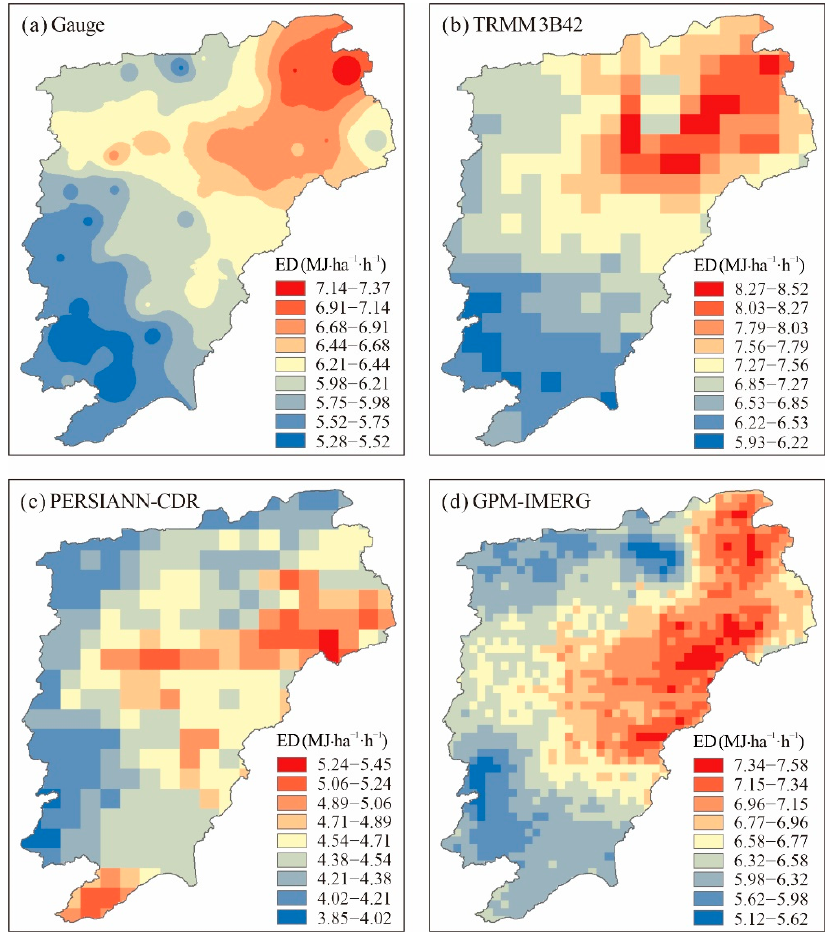
Figure 11. Comparison of spatial patterns of average annual erosivity density.